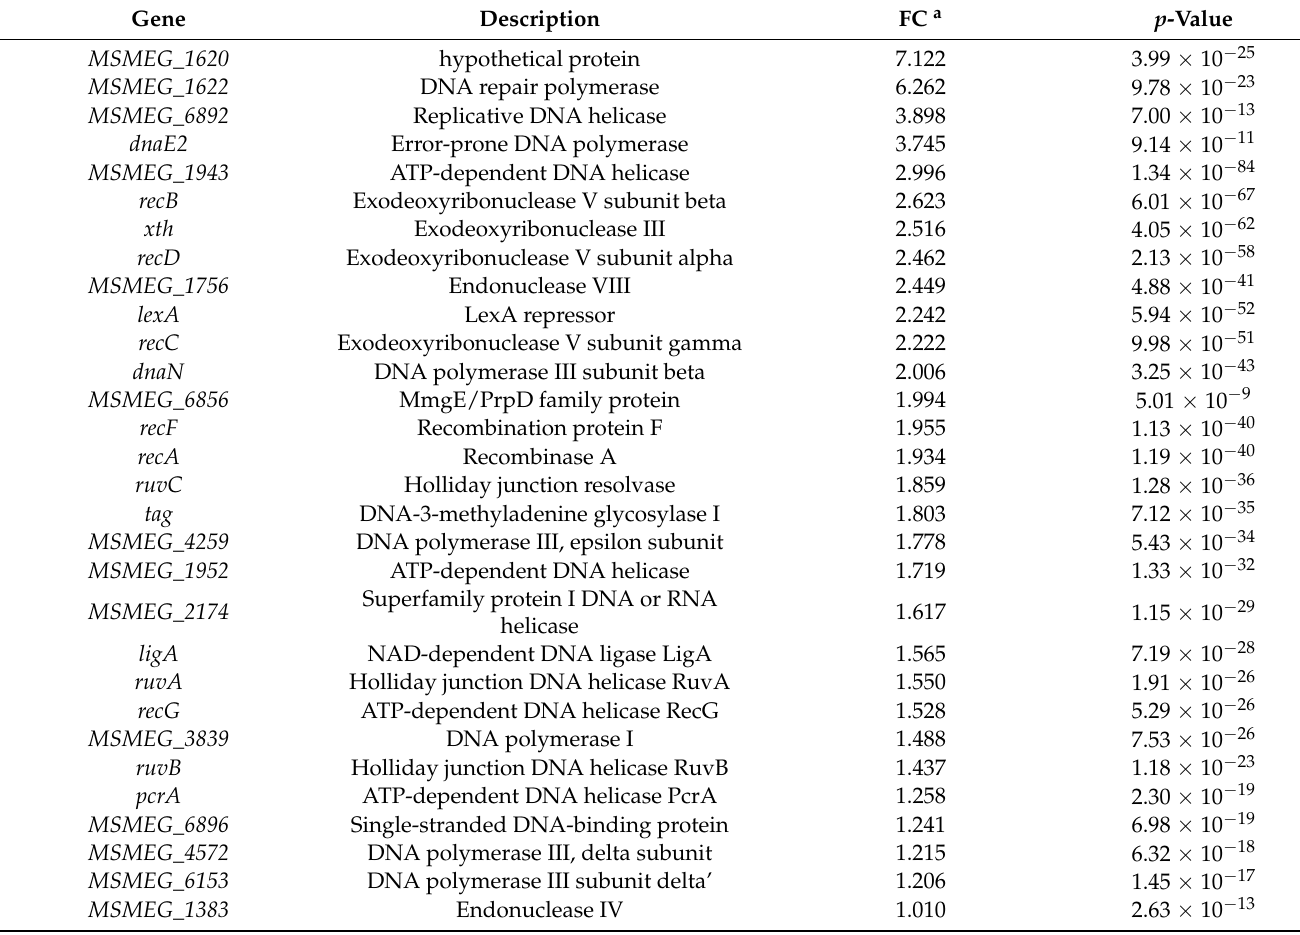
Table 1. Transcriptional profile of genes in the response to MEMSG_6762 expression reveals the DNA damage in M. smegmatis